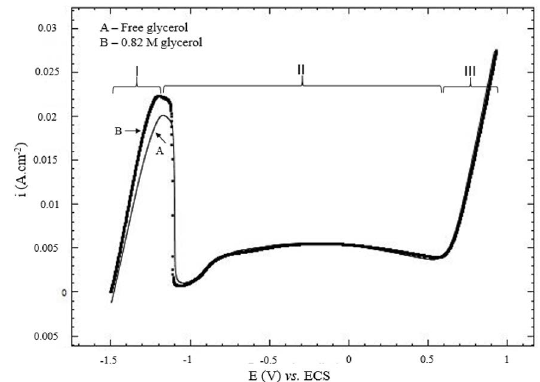
Figure 8. Potentiodynamic polarization curves of the zinc deposits in the absence of glycerol and 0.82 M of glycerol from a 2.00 M NaOH solution at a scanning speed of 10 mV.s -1